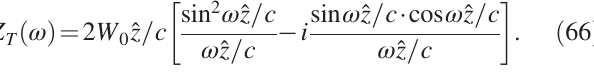
FIG. 12. The transverse impedance of the trapezoidal wake model. The real and the imaginary parts of the impedance are shown by the solid and the dashed lines,